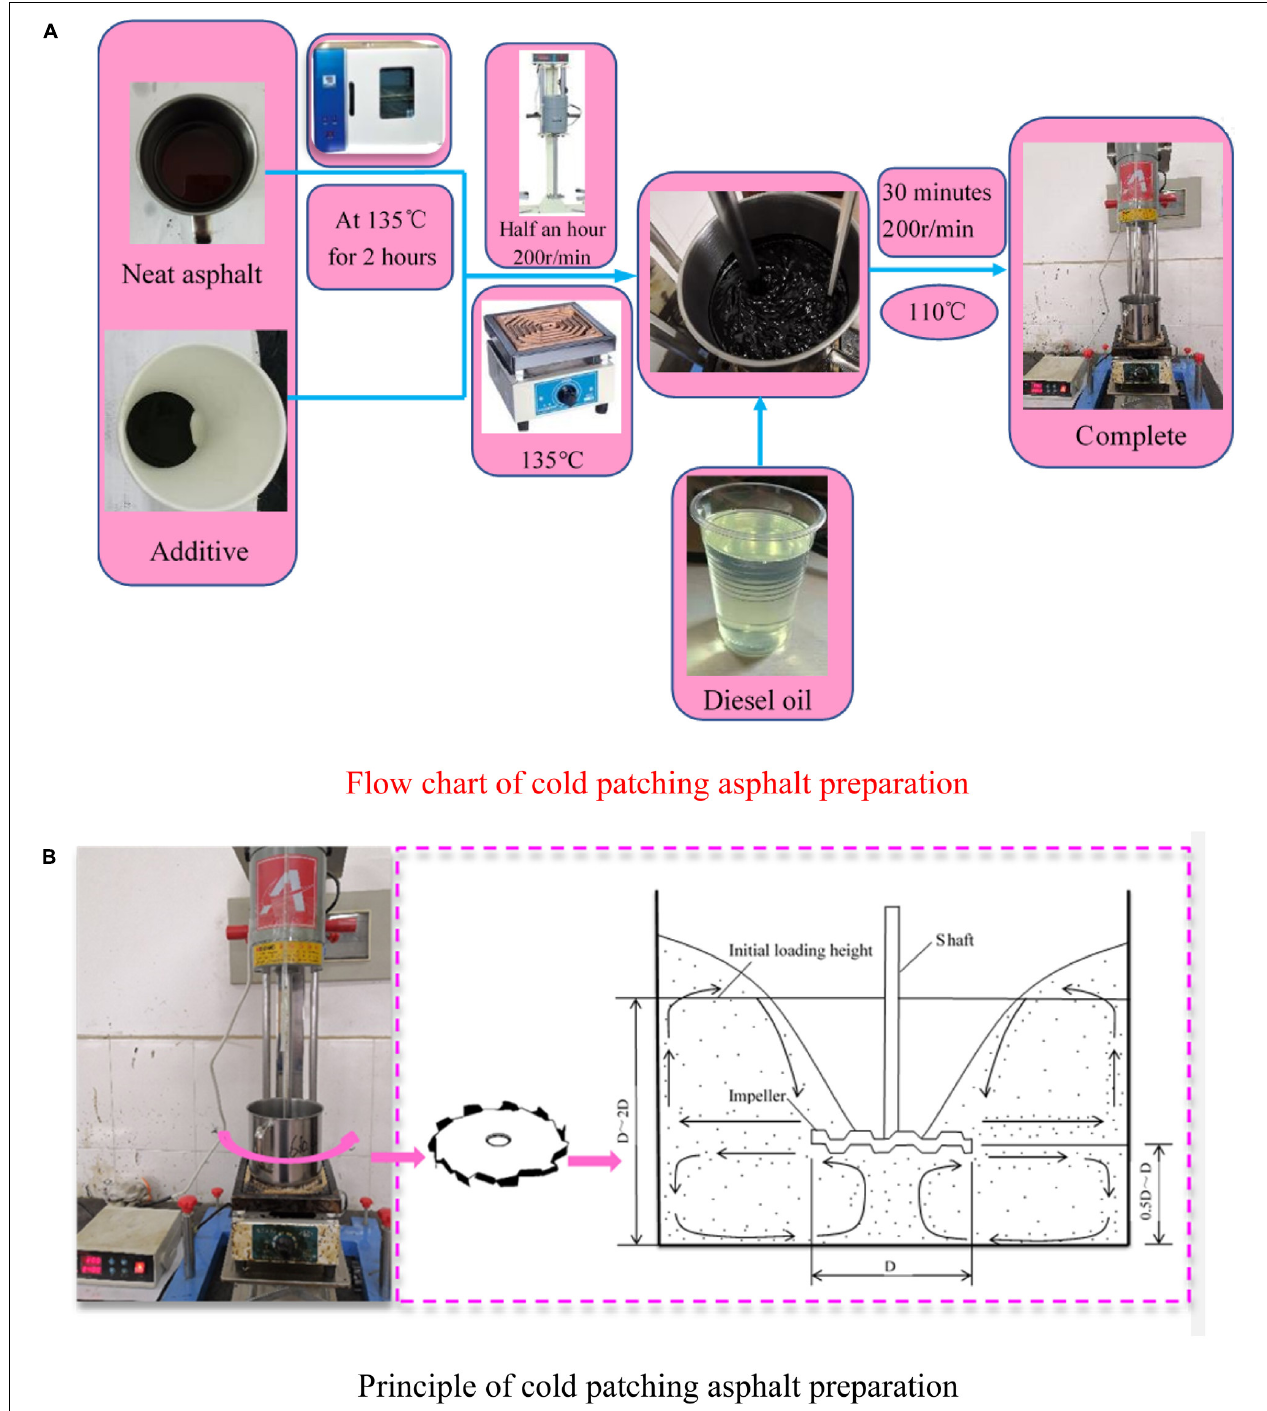
FIGURE 1 | Preparation of cold patching asphalt by disperser and the principle involved. (A) Flow chart of cold patching asphalt preparation. (B) Principle of cold patching asphalt preparation.